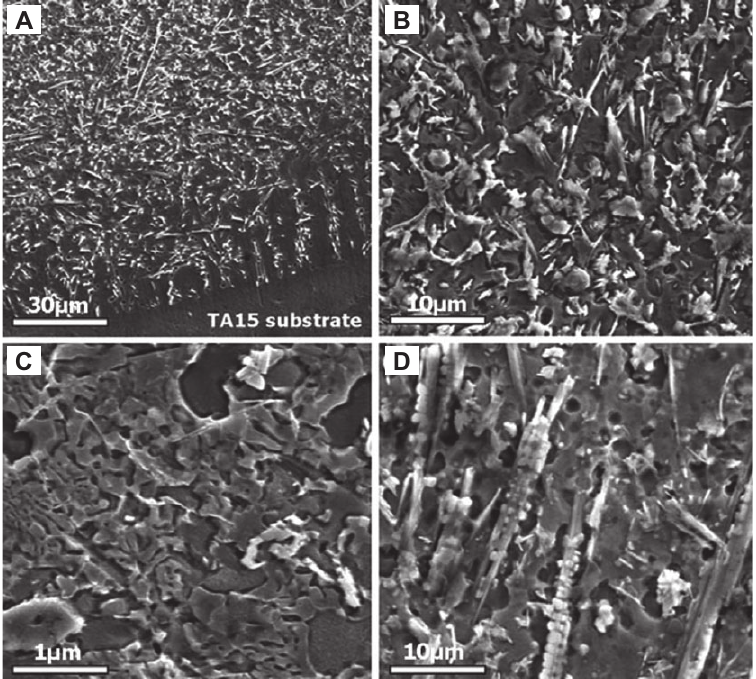
Figure 2 SEM micrographs of the composite coating in the sample, (A) the bonding zone, (B) the clad zone, (C) Ti-Co binary intermetallic alloy, and (D) microstructure.